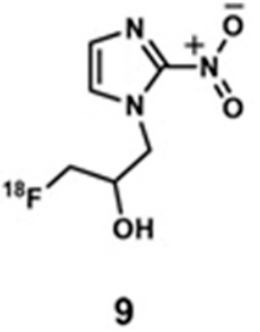
Figure 14. Chemical structure of 9 .